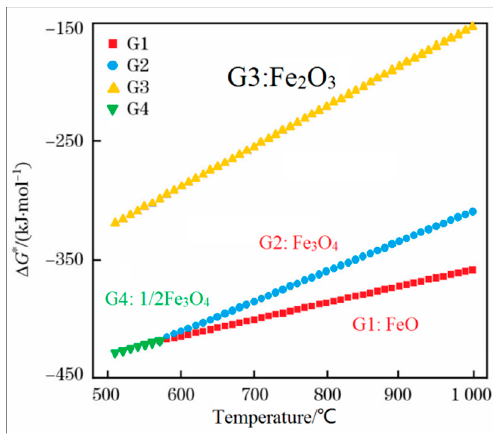
Figure 9. Thermodynamic diagram of the Fe-O oxides formation. Reprinted with permission from ref. [16].